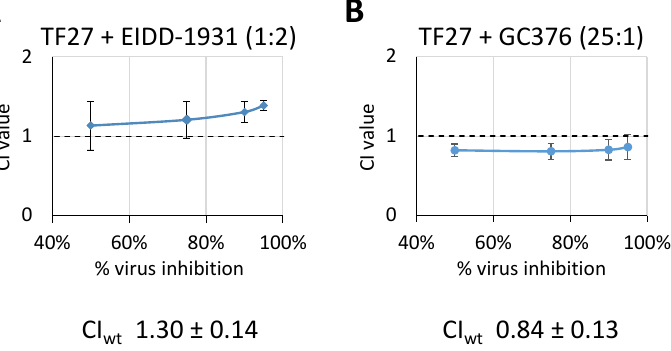
Figure 5. Combinatorial drug assessment of TF27 combinations with either EIDD-1931 or GC376 using the Loewe additivity fixed-dose method. Caco-2 cells were infected with SARS-CoV-2 d6-YFP at the MOI of 0.003 and treated with TF27, EIDD-1931, or GC376, either applied as single-drug treat- ment or as drug combinations of ( A ) TF27 + EIDD-1931 or ( B ) TF27 + GC376. Concentrations were matched for their respective EC 50 values, starting at 4 × EC 50 concentrations followed by seven two- fold dilutions. The ratio of the compound concentrations is indicated in parenthesis. Viral replica- tion was quantitated by measuring the cell-associated YFP fluorescence 28 h p.i. to determine dose responses. Subsequently, combination index (CI) values were calculated for 50, 75, 90, and 95% virus inhibition using the CompuSyn algorithm. The values represent the mean ± SD derived from three biological replicates. 4. Discussion 4.1. The Broad-Spectrum Antiviral Potential of Monomeric ART and Trimeric TF27 and Their Putative Relevance for the Development of Novel Anti-SARS-CoV-2 Treatment Strategies Researchers throughout the world have recently gained huge interest in the anti- SARS-CoV-2 potential of the approved and well-tolerated anti-malarial drugs from the artemisinin family, so that repurposing approaches for other infectious diseases appear generally appealing. Several in silico studies predicted ART to bind SARS-CoV-2 proteins, including the S protein, the viral proteases PLpro and 3CLpro by molecular docking and molecular dynamics simulations (reviewed in [60]). Early cell culture-based studies demonstrated ART anti-SARS-CoV-2 activities, however, at concentrations not achievable in humans or that are close to the in vitro cytotoxic concentrations [33–37]. These findings are consistent with our observations for the antiviral activity of monomeric ART. How- ever, the trimeric TF27 revealed a very substantial antiviral activity indicating that trimer- ization greatly enhances the anti-SARS-CoV-2 activity. Additionally, TF27 potently